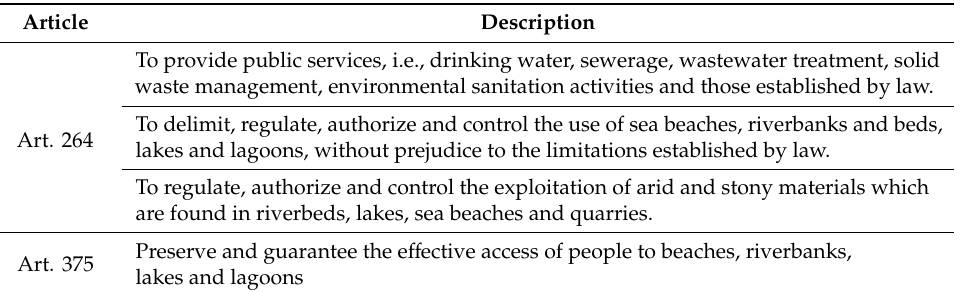
Table 7. Powers of the decentralized municipal governments in relation to the management of beaches (Constitution of